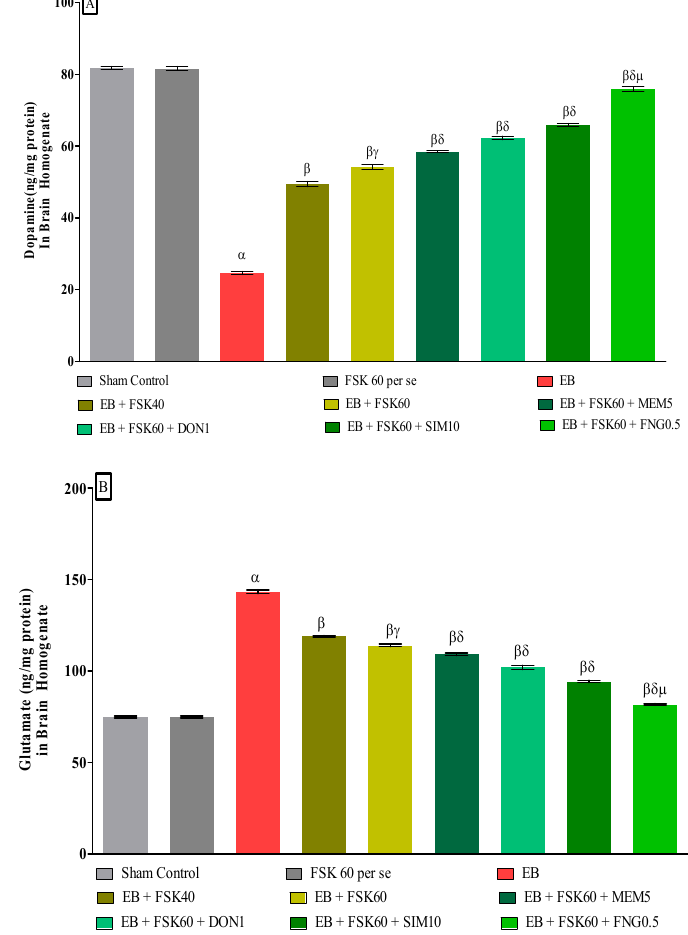
Figure 11. ( A , B ): Protective role of FSK on amelioration of neurotransmitter alteration levels in experimental multiple sclerosis rats. Analysis of Variance (ANOVA) with Tukey’s test was used to evaluate the data, which were presented as mean with SD ( n = 6). α EB (p < 0.01) v / s Sham control and FSK40 perse;